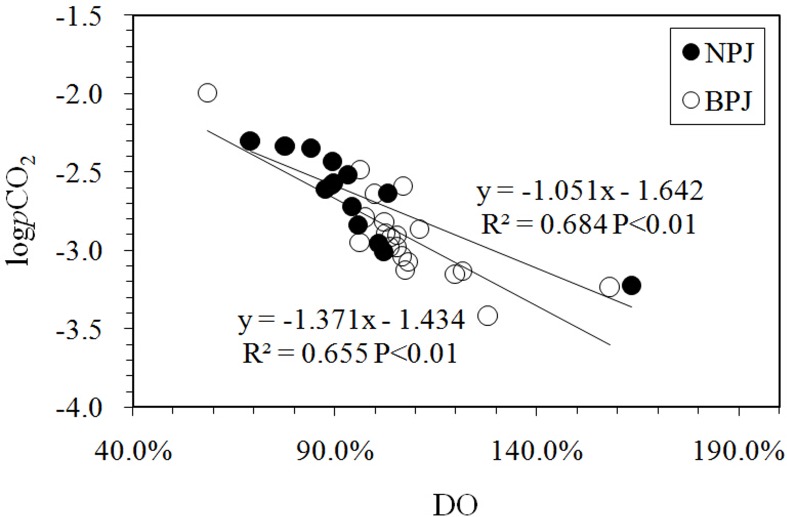
Variations in logPCO2 with DOC.Contrasting positive and inverse correlations were observed for the Nanpan and Beipan Rivers, respectively. See Fig 6 for logPCO2 data.